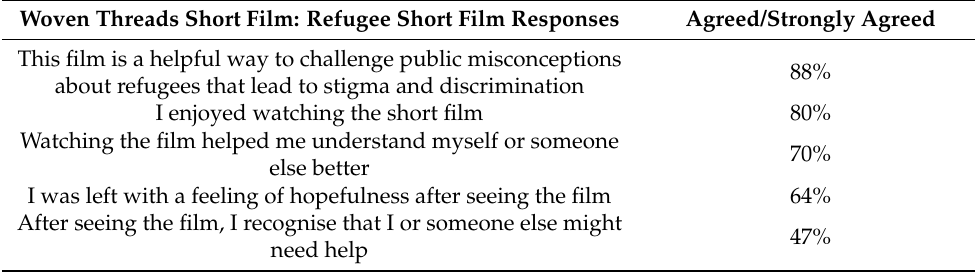
Table 2. Viewer responses to Woven Threads Refugee short film ( n =